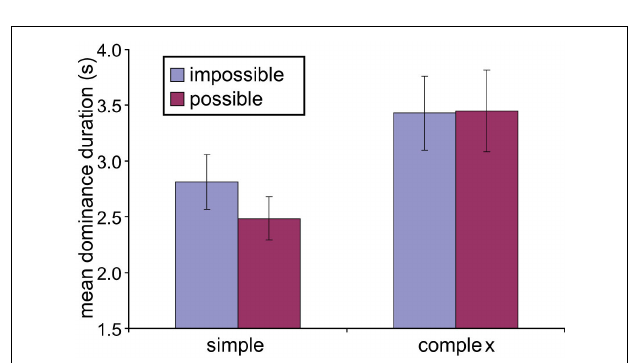
FIGURE 3 | Scatter plot showing mean dominance durations of non-words vs. words for each subject. All points are on or above the equivalence line: mean dominance durations for non-words were longer than for words. Note one observer had considerably longer dominance durations, plotted on an extended scale.